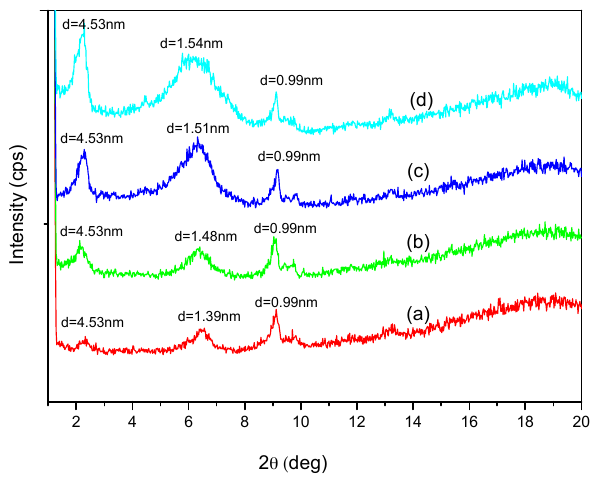
Figure 2. XRD curves of ( a ) NR/FR-DOMt-5, ( b ) NR/FR-DOMt-10, ( c ) NR/FR-DOMt-15, ( d ) NR/FR-DOMt-20.